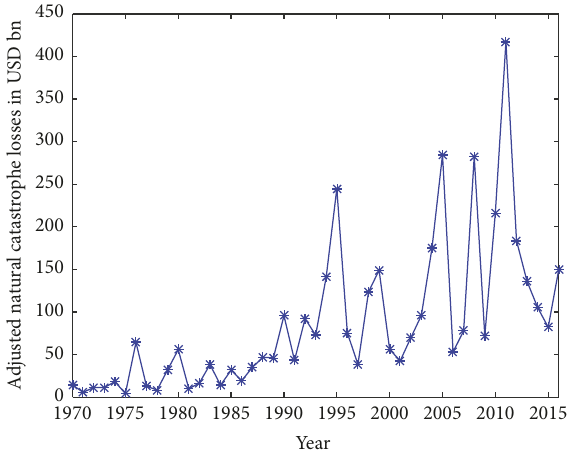
Figure 2: Adjusted total losses from natural catastrophes worldwide during 1970–2016 (USD billion, 2016 prices).